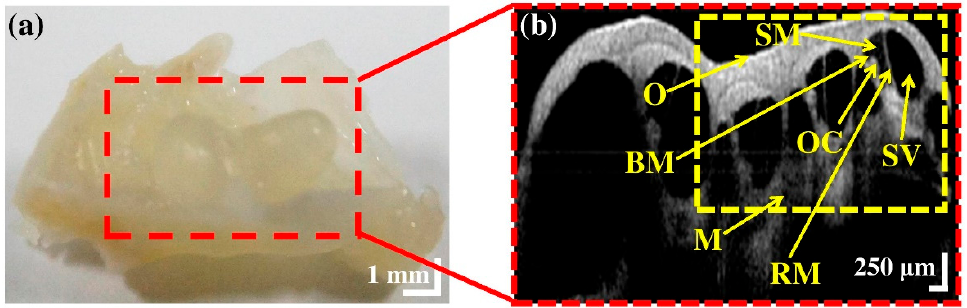
Figure 2. External appearance of a guinea pig cochlea and cross-sectional representation. ( a ) The photograph of a guinea pig cochlea sample; ( b ) Cross-sectional image acquired using the 1060 nm OCT system. BM: Basilar membrane, M: modiolus, OC: organ of Corti, O: otic capsule, RM: Reissner’s membrane, SM: scala media, SV: scala vestibuli.